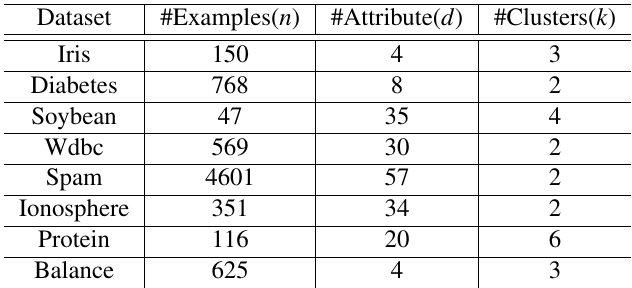
Table 2. Dataset